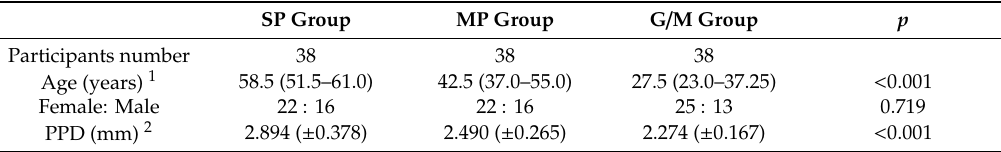
Table 1. Demographic and clinical data of study